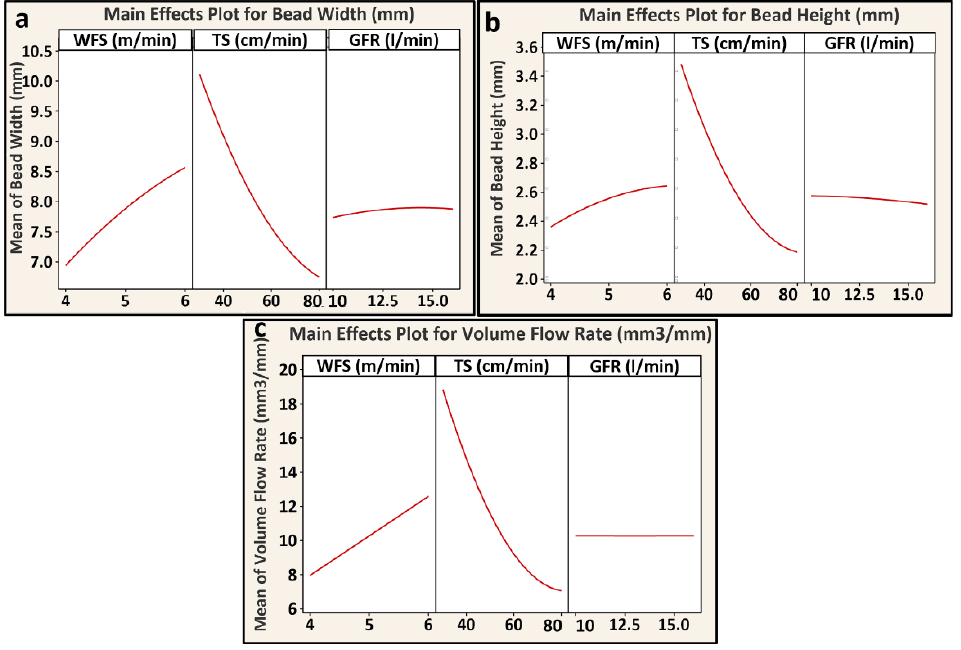
Figure 9. The main effect plots for ( a ) BW, ( b ) BH, and ( c ) volume flow rate with respect to the WFS, TS, and GFR made with the aid of Minitab software.